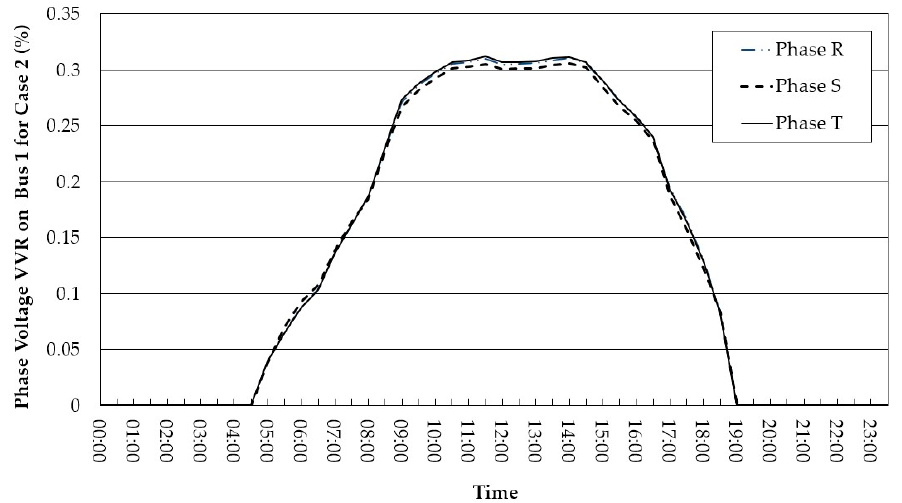
Figure 18. Three-phase VVR variation on Bus 1 for Case 2.